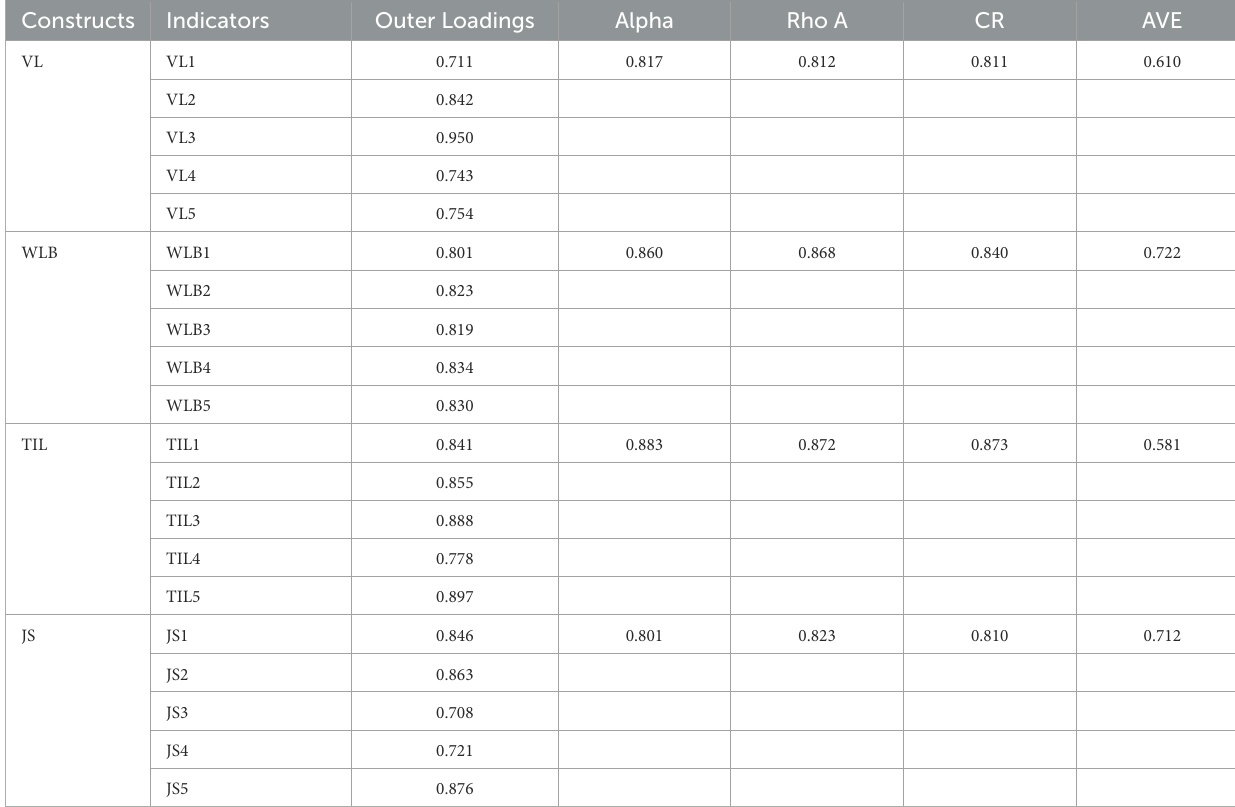
TABLE 3 Measurement model.